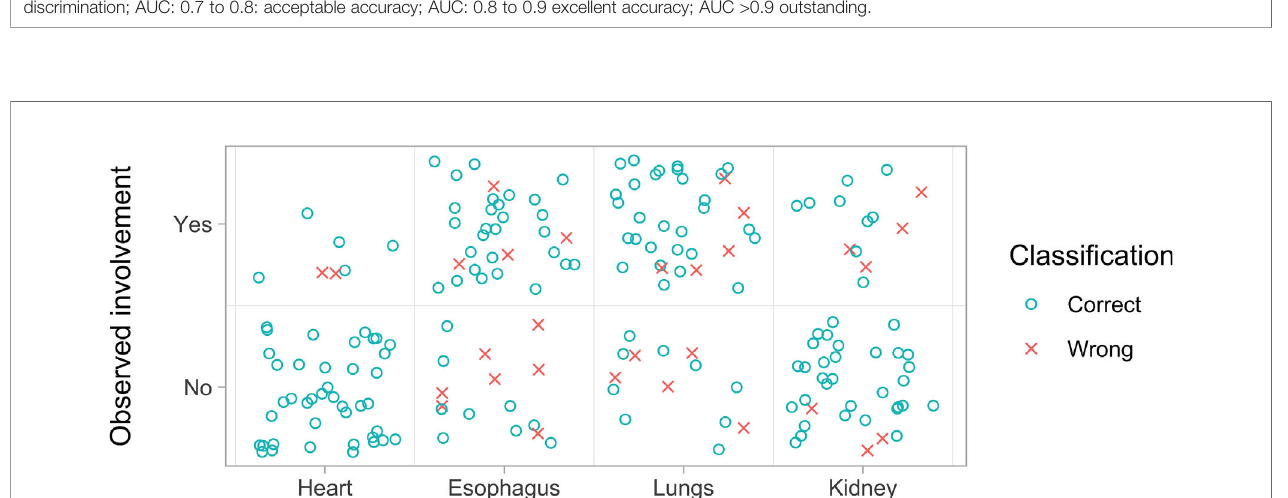
FIGURE 3 | evaluation of the model ’ s predictive capacity: ROC curve of all the four organs investigated (left side) and overall (right side): for each organ investigated the AUC of esophagus, heart, lung, and kidney were 0.720, 0.838, 0.809 and 0.84 respectively. Combining the four site-speci fi c probability, the fi nal model presents an AUC of 0.871 with an accuracy of 84.4% (95%CI 78, 89), 86% of sensitivity and 83% of speci fi city. Cohen ’ s Kappa (k) of 0.68. Legend: AUC = 0.5: no discrimination; AUC: 0.7 to 0.8: acceptable accuracy; AUC: 0.8 to 0.9 excellent accuracy; AUC >0.9 outstanding.